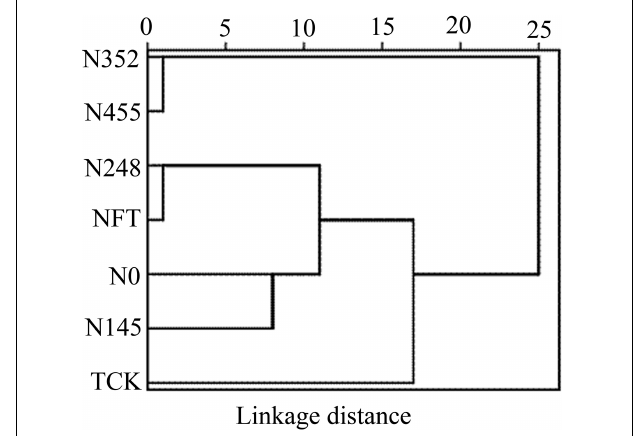
FIGURE 3 | Cluster analysis (Euclidean distances, Ward’s hierarchical method) based on soil and leaf physiological factors of different treatments.